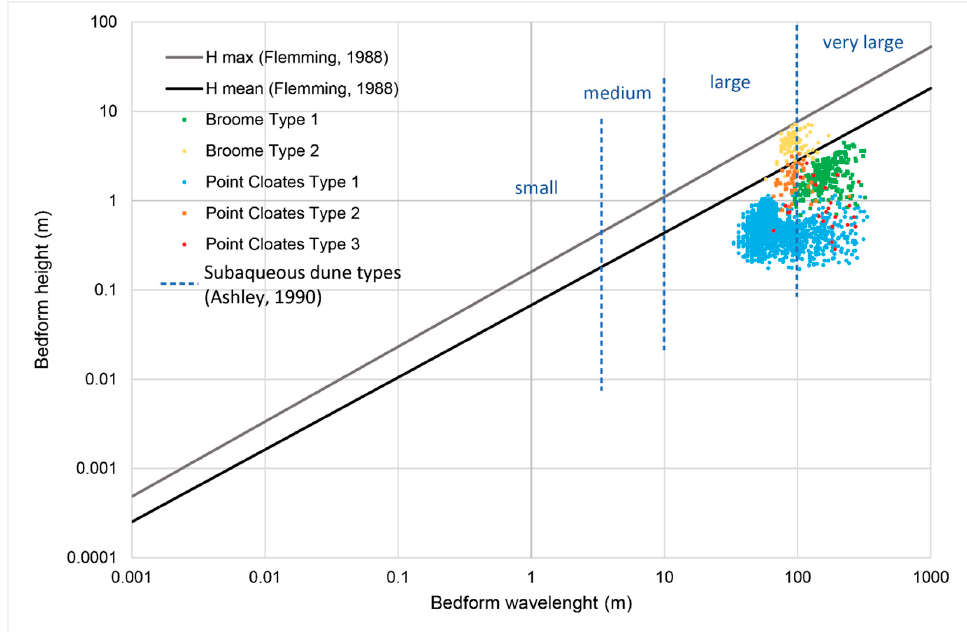
Figure 16. Comparison of the bedform height and wavelength (regarded as an approximation of the width in this study) on top of the trends H max and H mean from [16] and of the bedform size boundaries from [15].